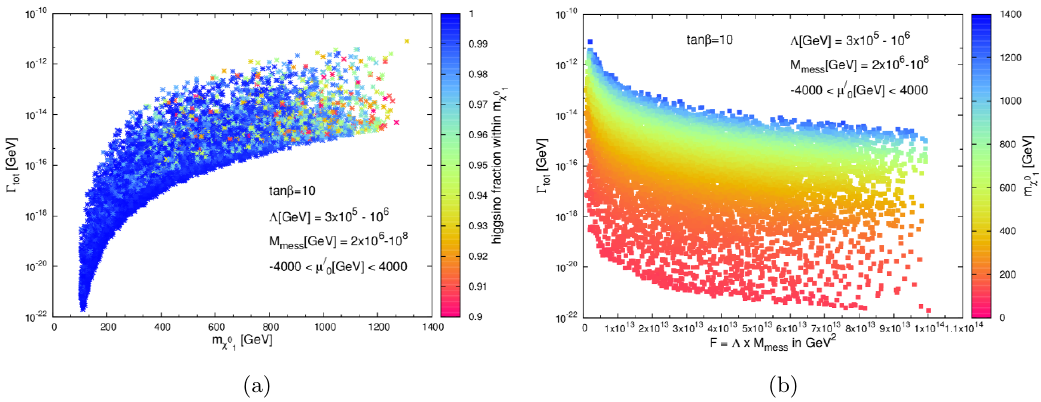
Figure 9 . (a) Scatter plot of decay width (cid:0) tot vs. m for a higgsino dominated NLSP over e (cid:31) 0 1 the scanned parameter region of eq. (3.2). The higgsino fraction is shown in graded color with a reference color bar on the right. (b) Similar scatter plot in the plane of (cid:0) tot vs. F where the NLSP mass is shown in a graded color with a reference color bar on the